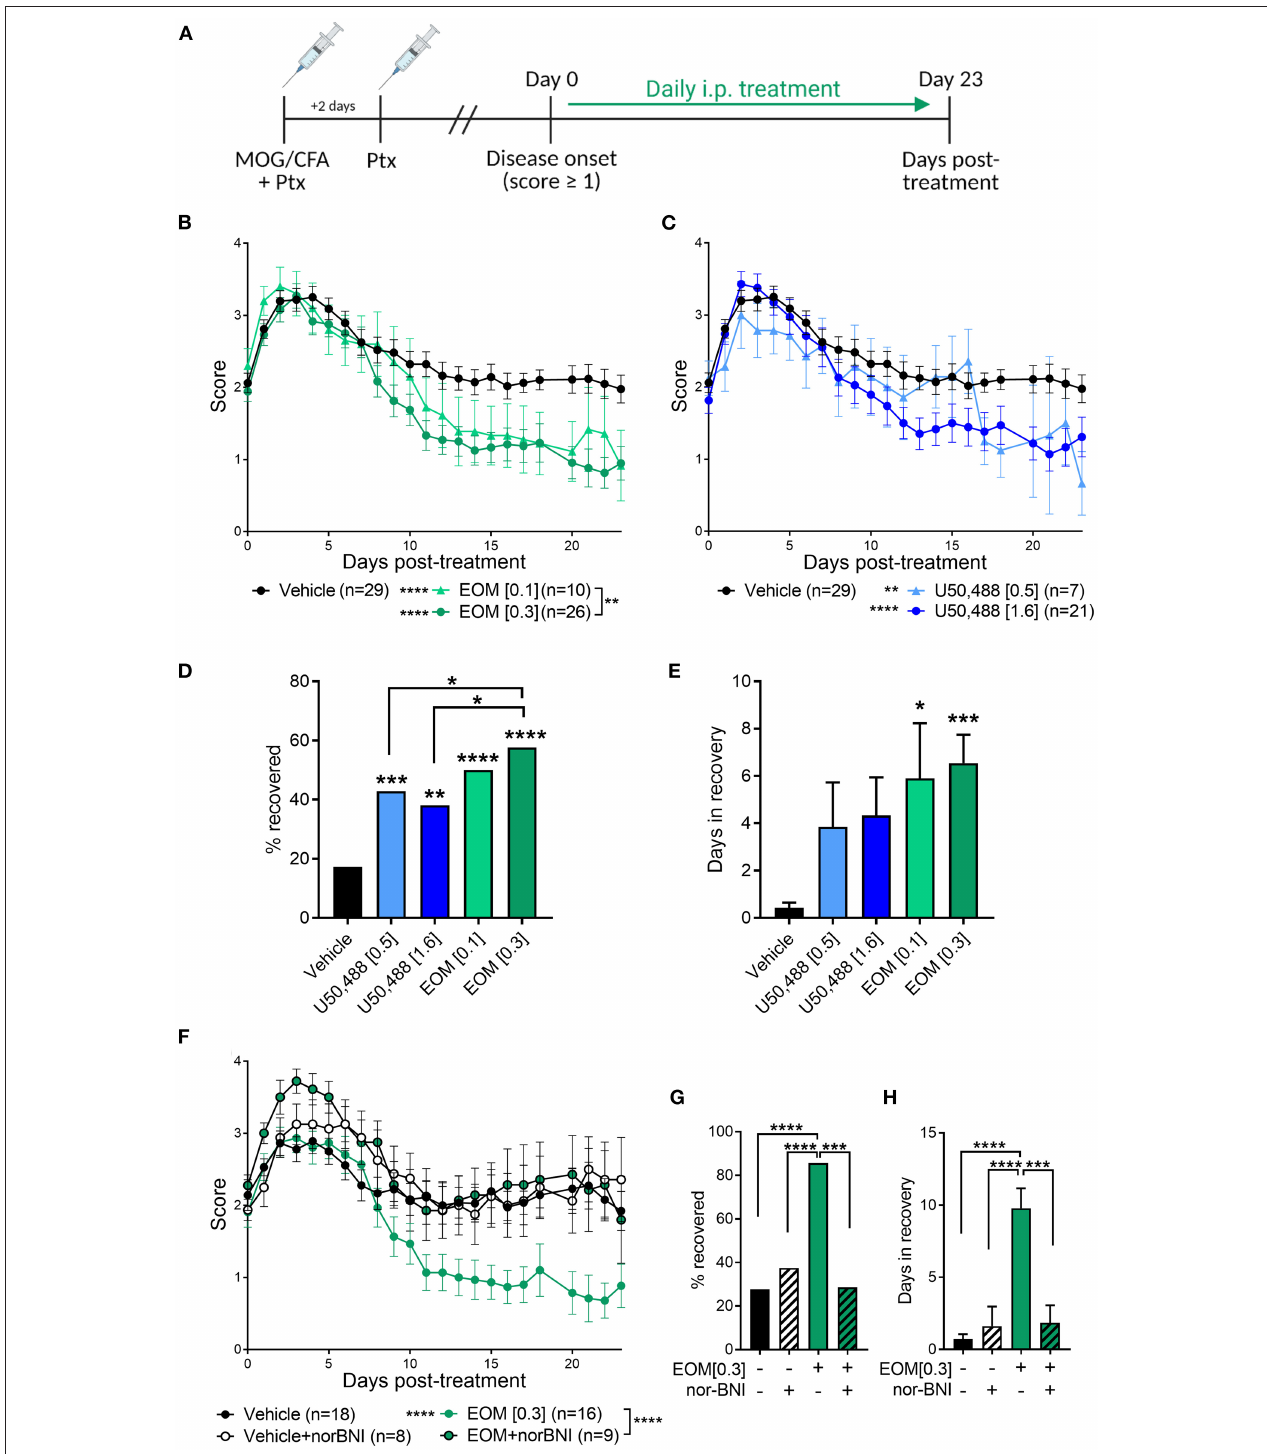
FIGURE 2 | In experimental autoimmune encephalomyelitis (EAE) mice, treatment with EOM SalB was more effective than U50,488 at enabling KOR-mediated functional recovery. (A) Mice were immunized with myelin oligodendrocyte glycoprotein (MOG) in complete Freund’s adjuvant (CFA) with pertussis toxin (Ptx) and treated daily from onset (score ≥ 1) with vehicle, EOM SalB or U50,488. (B) Disease score of EOM SalB or (C) U50,488 treated mice from disease onset to day 23. Scores aligned to the day of disease onset (day 0 post-treatment). Results are combined from 3-7 independent experiments ( n = 7–29, as indicated). (D) Percentage recovery to 23 days post-treatment (recovery = score ≤ 0.5). Fisher’s exact test for % recovery compared to vehicle or EOM SalB (0.3 mg/kg). (E) Number of days in